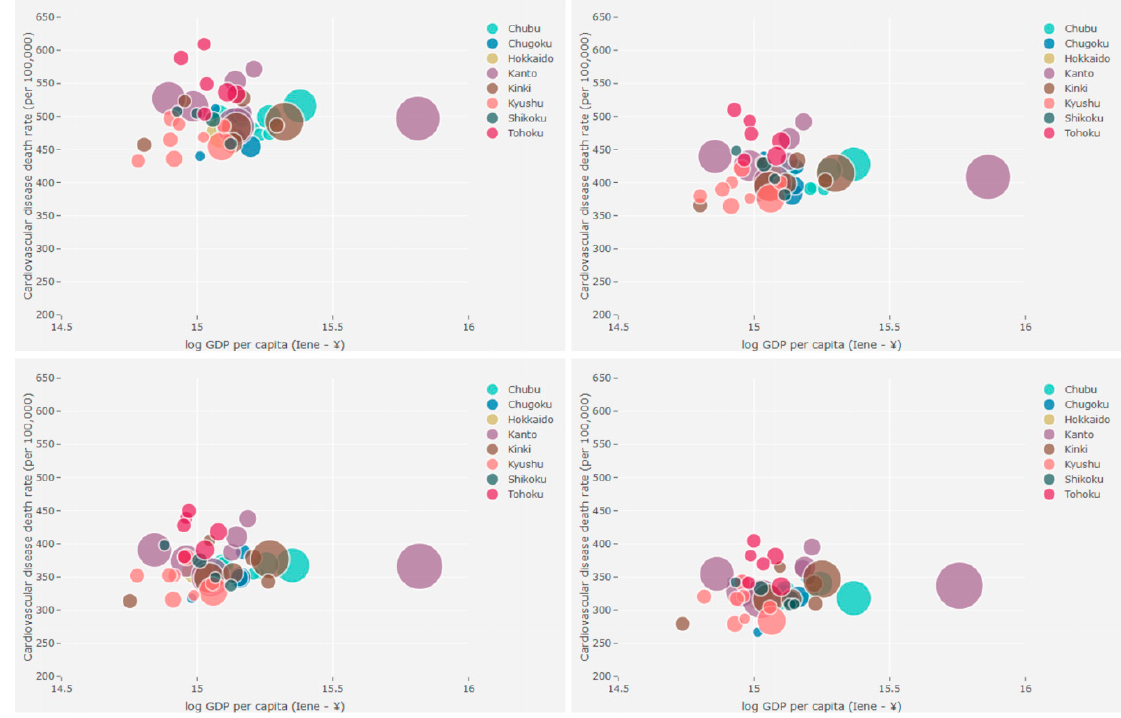
Figure 4. CVD mortality rates vs. GDP per capita vs. population, males, prefectures, Japan—time series 1996–2000 ( top left ), 2001–2005 ( top right ), 2006–2010 ( bottom left ), and 2011–2015 ( bottom right ).